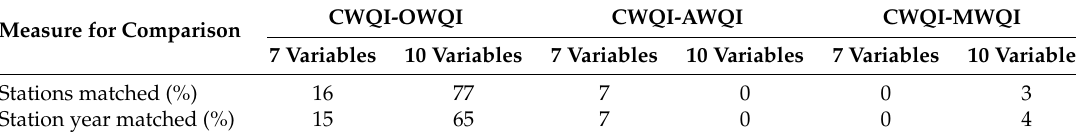
Table 6. Measures for comparison between Canadian (CWQI) and US-based WQI s [40]. Measure for